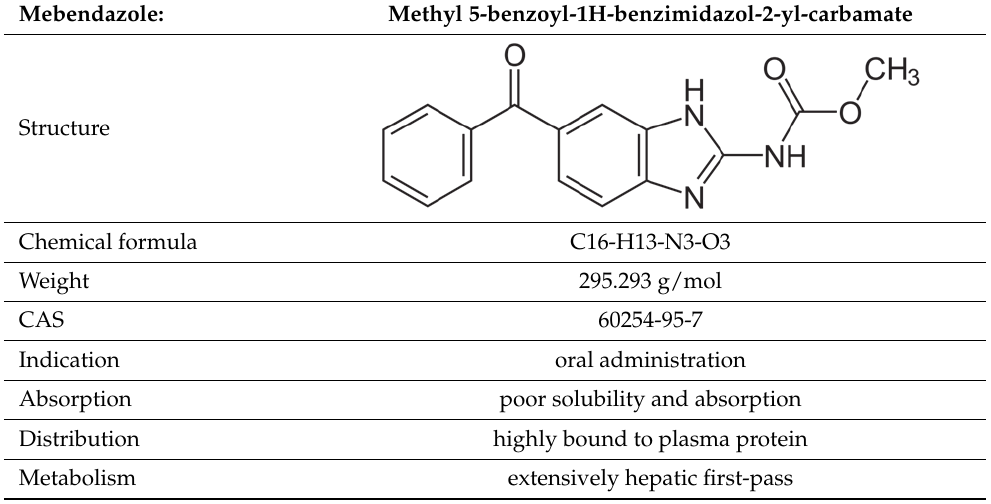
Table 1. Chemical properties of MBZ.